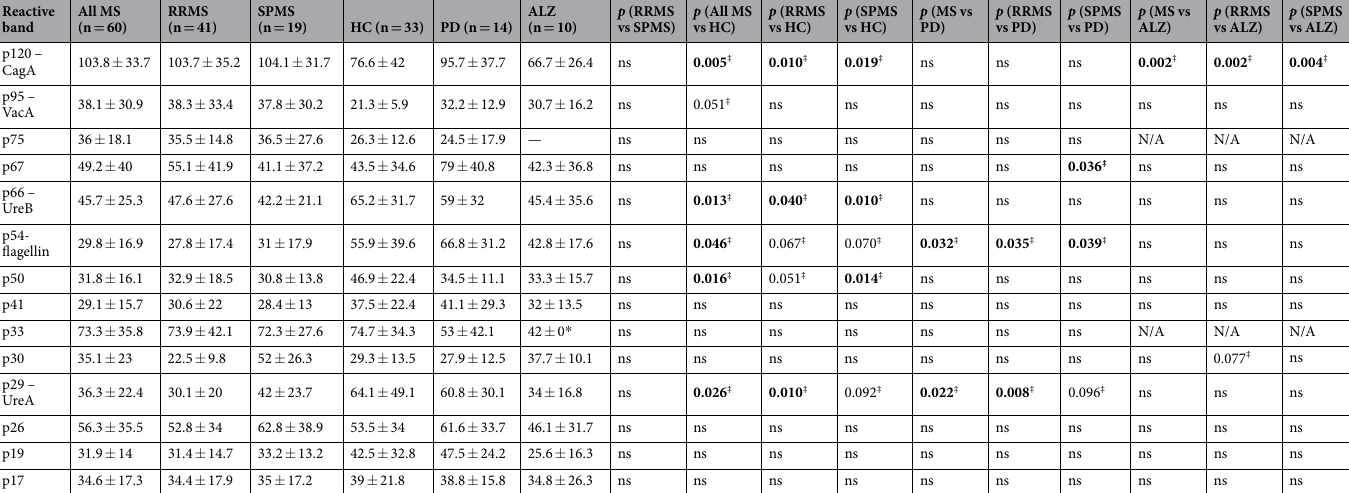
Table 3. Magnitude of antibody responses against immunoreactive Hp-specific antigens as measured by Western immunoblotting in sera of 60 anti-Hp( + ) patients with multiple sclerosis (MS), including 41 relapsing-remitting (RRMS) patients and 19 secondary progressive (SPMS) patients, 33 anti-Hp( + ) healthy controls (HC), 14 anti-Hp( + ) patients with Parkinson’s disease (PD) and 10 anti-Hp( + ) patients with Alzheimer’s disease (ALZ). Data on the magnitude of antibody responses are expressed as mean ± standard deviation arbitratry units (AU) (see methods). ‡ p-values were calculated using 2-tailed t-test for Equality of Means, equal variances were not assumed. p -values < 0.05 are shown in bold; * , n = 1; p -values with a statistical tendency ( < 0.1) are also